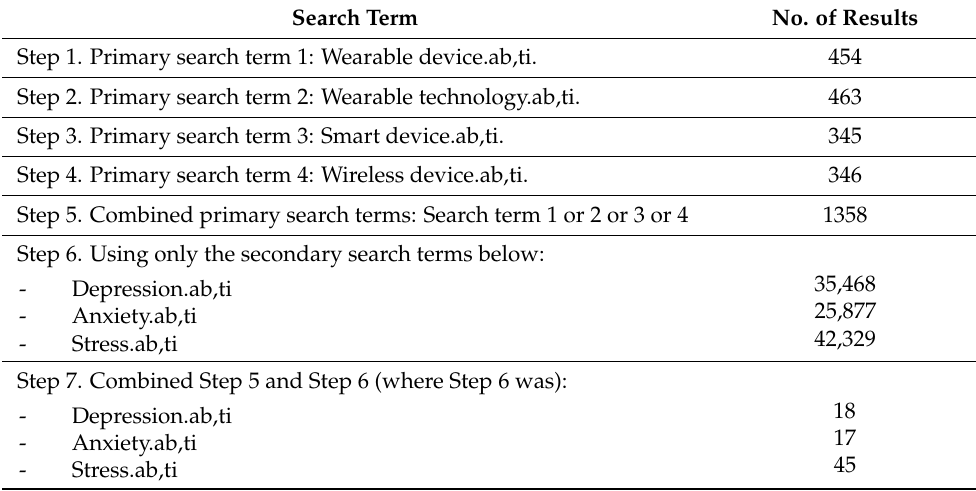
Table 2. The search structure for the CINAHL Plus database. Search